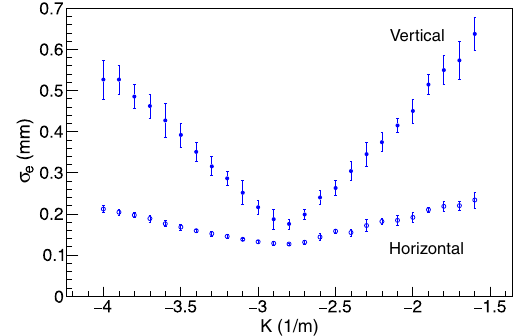
FIG. 20. Tuning of the electron beam sizes by the Q -scan using screen monitor at the